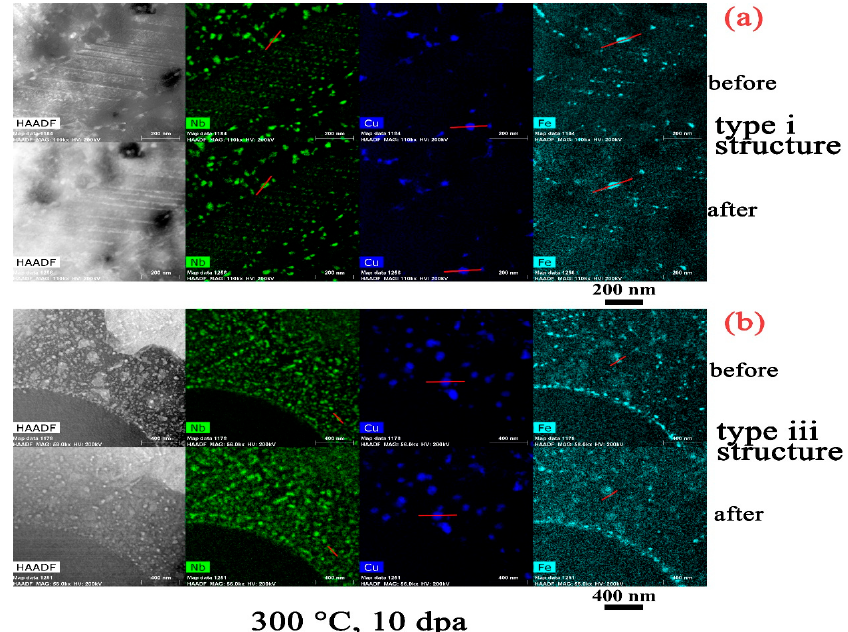
Figure 4. HAADF and Chemi-STEM micrographs showing the distribution of Nb, Cu, and Fe alloying elements before and after heavy ion irradiation at 300 °C to 10 dpa in ( a ) type i and ( b ) type iii structures. Red lines in the maps indicate the precipitates used for the element distribution line profile measurement.